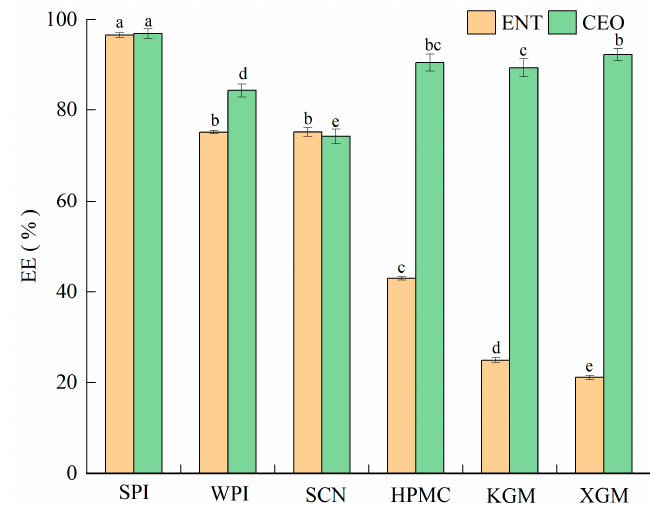
Figure 1. The encapsulation efficiency (EE) of enterocin Gr17 (ENT)/cinnamaldehyde (CEO) in nanoemulsions produced by using soybean protein isolate (SPI), whey protein isolate (WPI), sodium caseinate (SCN), hydroxypropyl methyl-cellulose (HPMC), konjac gum (KGM) and xanthan gum (XGM). Means with no letter in common are significantly different ( p < 0.05).